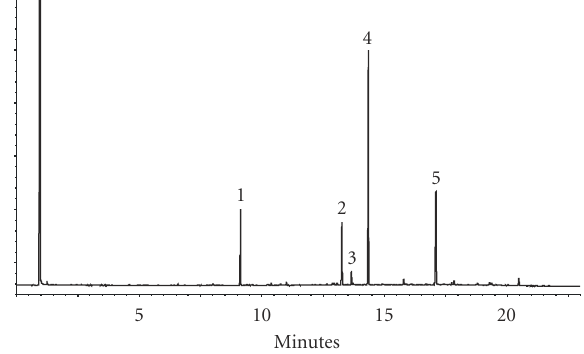
Figure 1: Gas chromatogram for di ff erent alkaloids (1 ISTD- Ca ff eine, 2 Angustifoline, 3 Iso-Lupanine, 4 Lupanine, 5 13- Hydroxy-Lupanine) present in cultivar Haags Blaue grown at